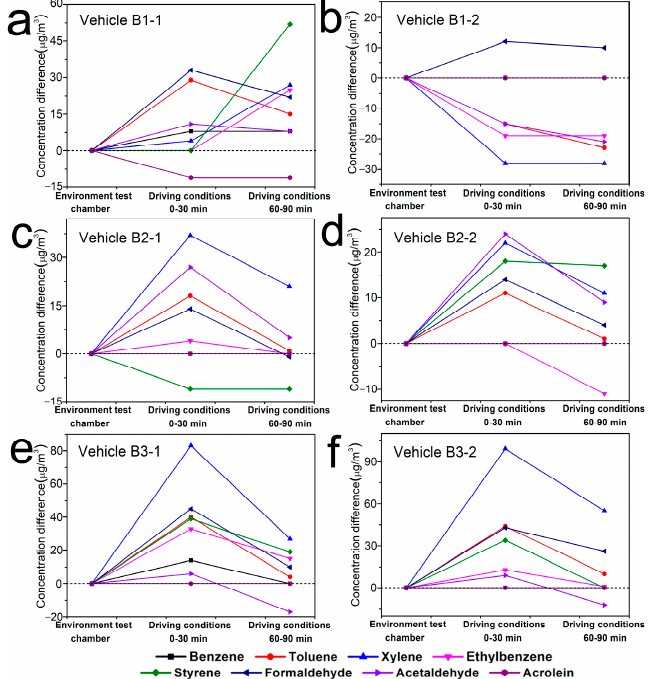
Figure 4. Concentration changes of eight confirmed compounds inside six vehicles of Brand B under different conditions (( a ). Vehicle B1-1; ( b ). Vehicle B1-2; ( c ). Vehicle B2-1; ( d ). Vehicle B2-2; ( e ). Vehicle B3-1; ( f ). Vehicle B3-2). Y -axis indicates the concentration difference between C D(0–30min) and C E , C D(60–90min) and C E .